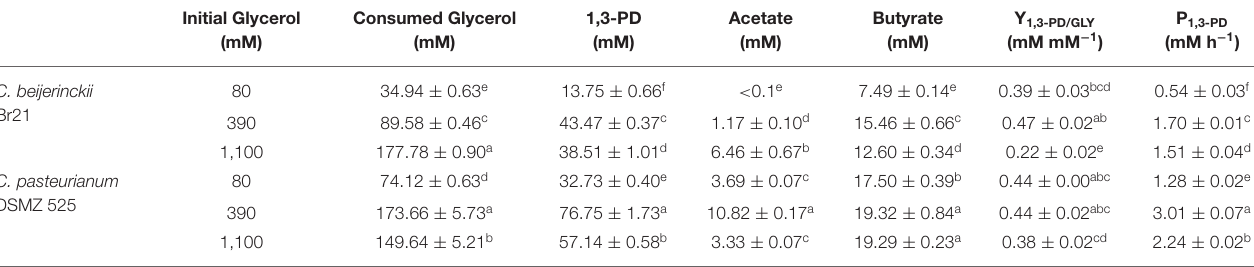
TABLE 1 | Glycerol consumption, product concentrations, yields, and fermentation productivities by C. beijerinckii Br21 and C. pasteurianum DMSZ 525 in different initial glycerol concentrations. Initial Glycerol